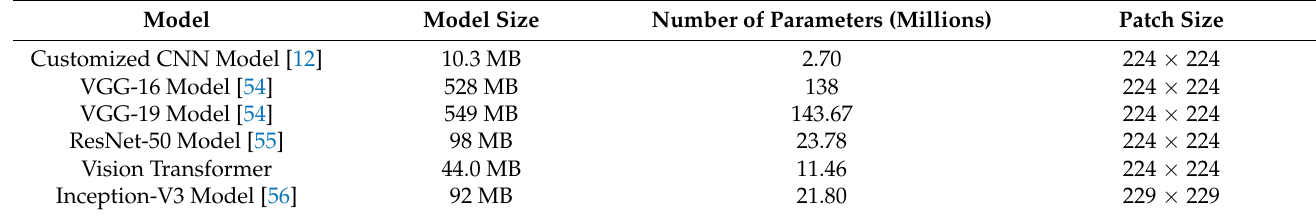
Table 2. Model specifications used in the proposed study.